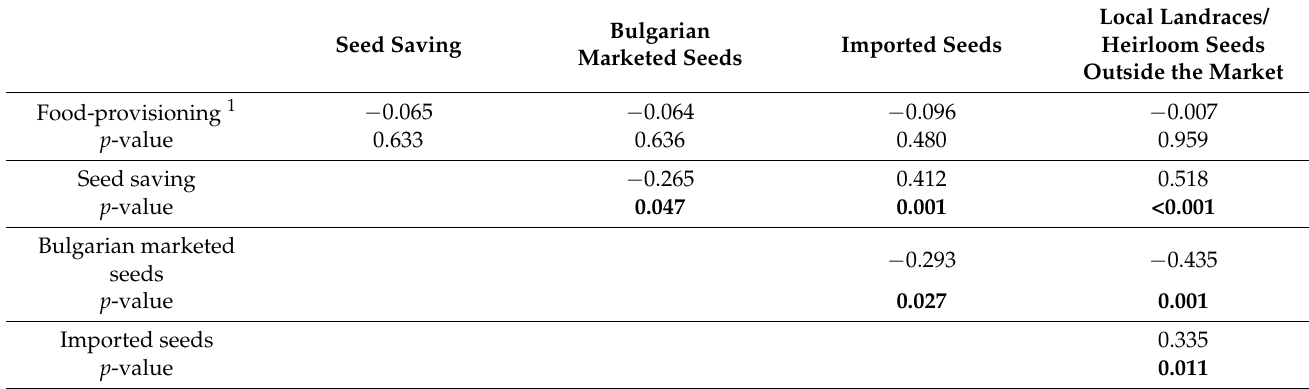
Table 5. Personal preferences for seed saving in relation to food